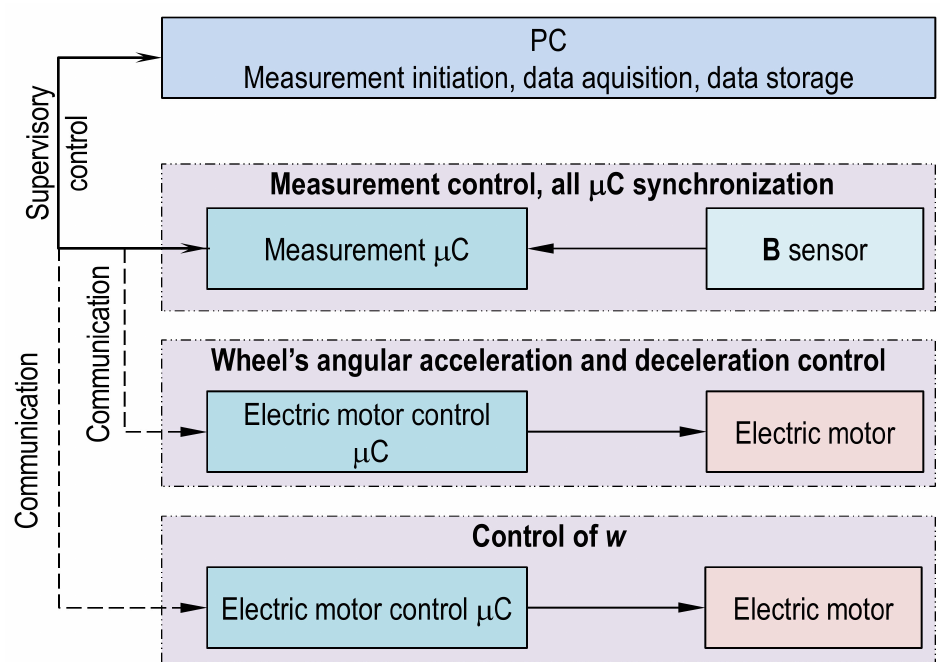
Figure 5. Schematic of microcontroller system layout and primary function of every microcontroller ( µ